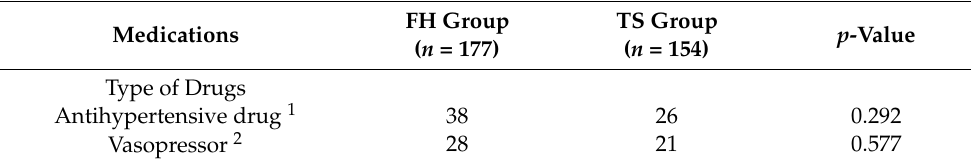
Table 3. The number of patients who needed medications.